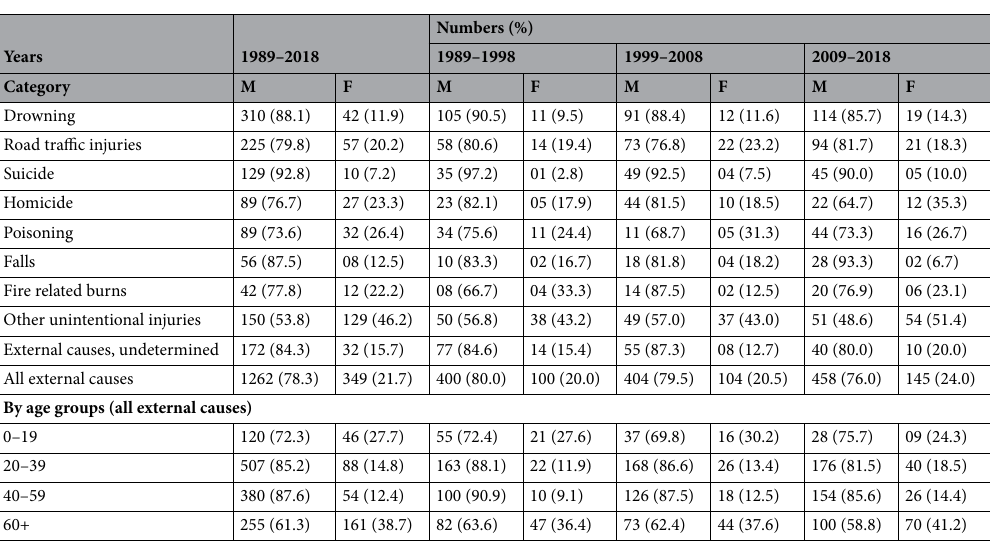
Table 1. Descriptive statistics. M males; F